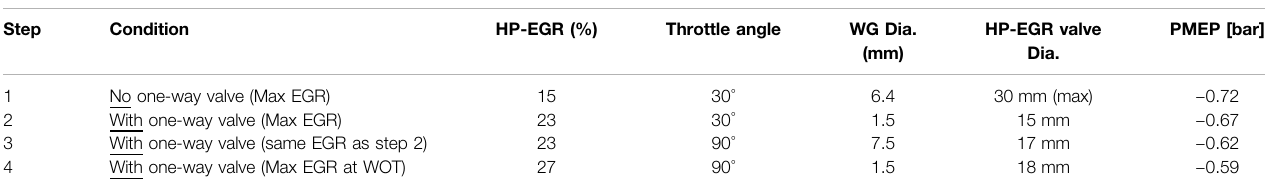
TABLE 4 | HP-EGR operation expansion with one-way